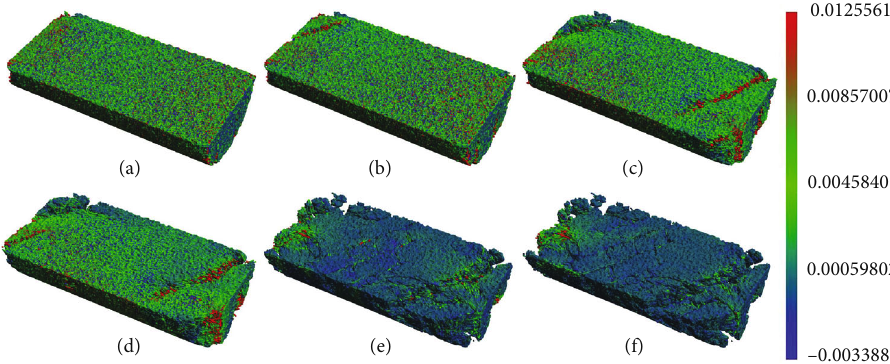
Figure 13: Diagram of the failure process of solid bond elements inside the 30 ° bedding model. The color bar represents the magnitude of the solid bond force